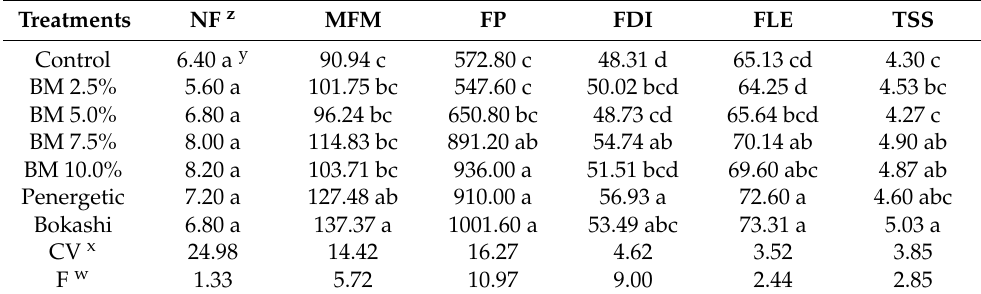
Table 1. Fruit production variables of tomato (cv. Guac á ) fertilized with boiled manure (BM), Penergetic, or Bokashi. First cycle. Londrina, Brazil, 2015. Treatments